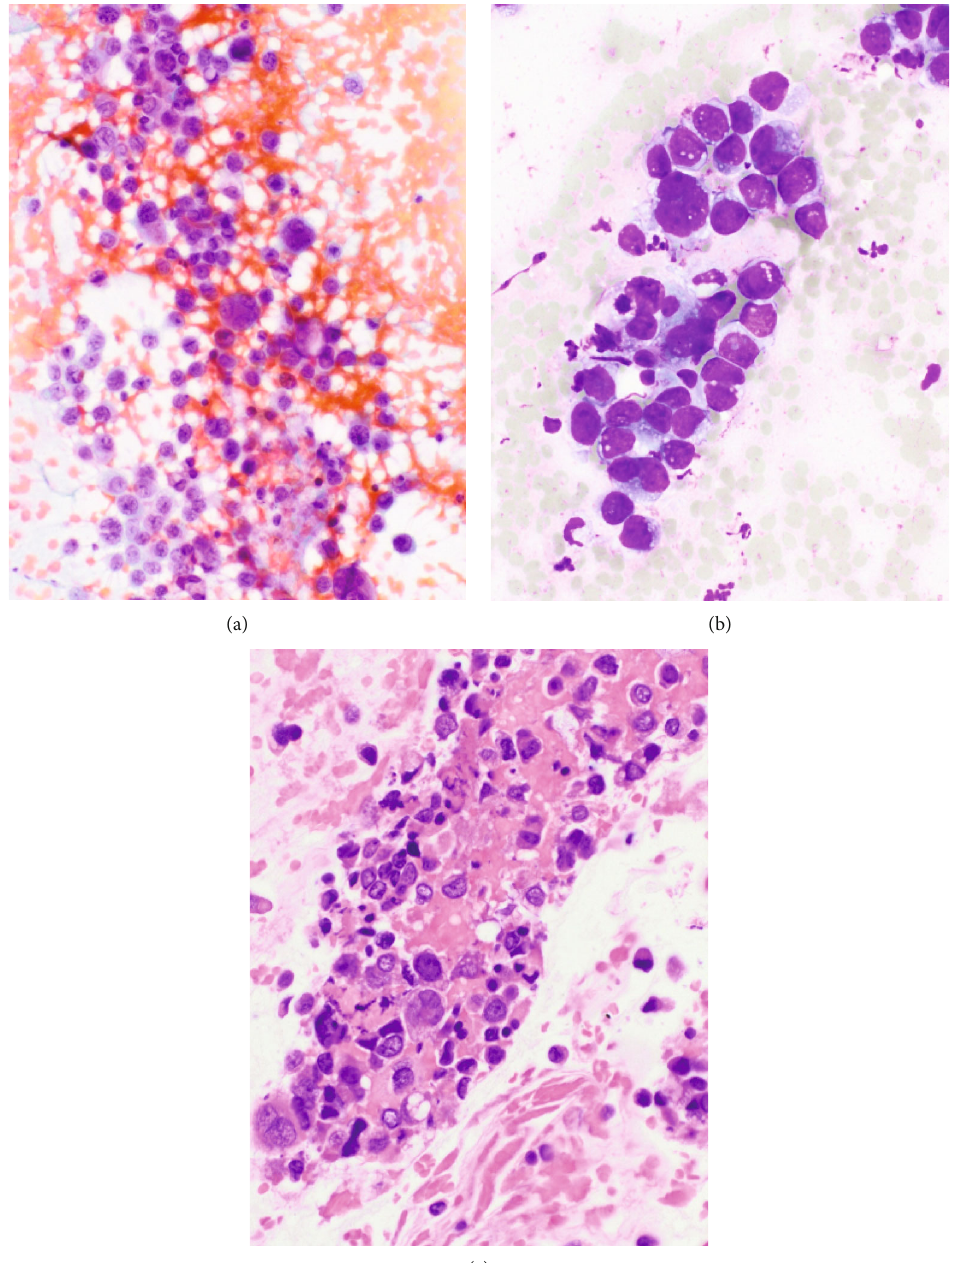
Figure 1: (a) High cellularity EUS FNA direct smear with loosely cohesive neoplastic cells with open chromatin and discernable nucleoli in backgrounds of blood (Papanicolaou stain, 400X). (b) Higher magni fi cation EUS FNA direct smear with cohesive groups of high nuclear/ cytoplasmic ratio malignant cells with vague acinar architecture compatible with adenocarcinoma (modi fi ed Giemsa stain, 600X). (c) Cell block preparation with background eosinophilic granular debris (necrosis) and scattered overtly cytologically malignant individual cells with hyperchromasia and anisonucleosis (hematoxylin and eosin stain,